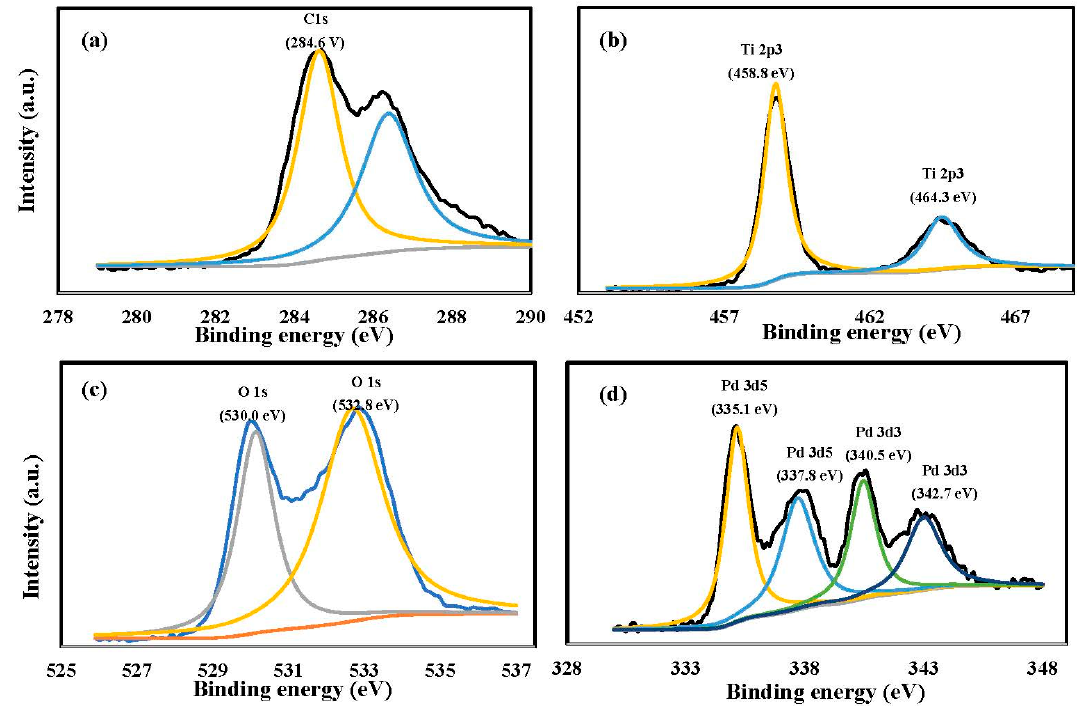
Catalysts 2020 , 10 , x FOR PEER REVIEW Figure 3. XPS analysis of Pd / TNAs-C ( a ) C 1s, ( b ) Ti 2p, ( c ) O 1s, and ( d ) Pd 3d5 3d3. Figure 3. XPS analysis of Pd/TNAs-C ( a ) C 1s, ( b ) Ti 2p, ( c ) O 1s, and ( d ) Pd 3d5 3d3. Table 1. The percentage of each element by XPS analysis of Pd/TNAs, Pd/TNAs-C and Pd/TNAs-G.